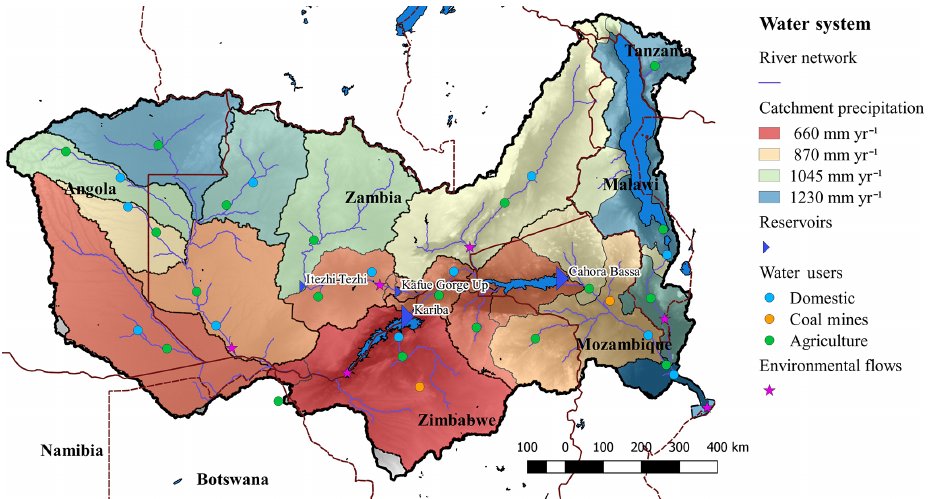
Figure 3. The water system representation. The river basin is divided into hydrological catchments defining the river network, and a rainfall– runoff model gives water availability. Reservoirs can store and release water. Water users represent large non-agricultural consumption, such as mining.